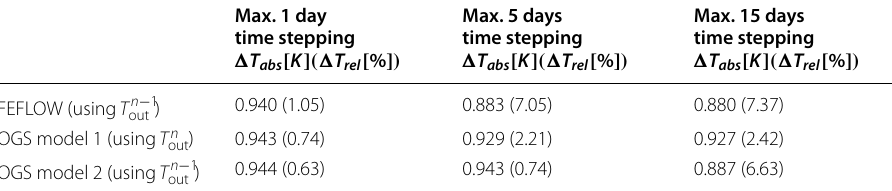
Table 4 Temperature difference comparison for different numerical